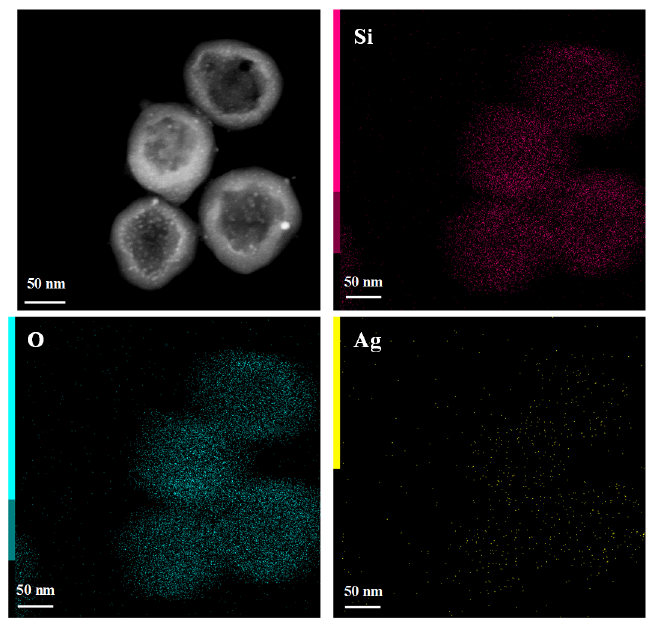
Figure 3. Dark field image of hollow Ag@SiO 2 spheres and energy-dispersive X-ray spectroscopy (EDX) elemental mapping of Si, O, and Ag elements of hollow Ag@SiO 2 .